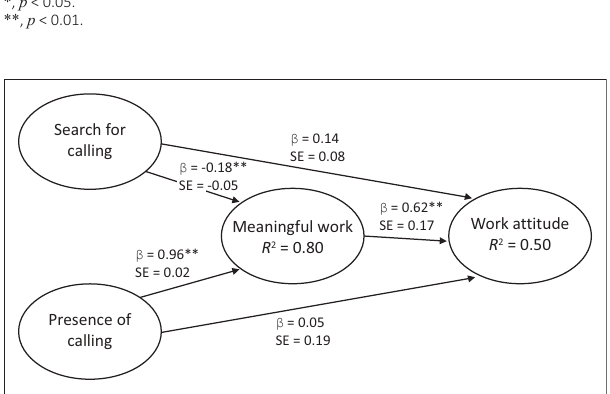
FIGURE 2: Standardised path coefficients for model